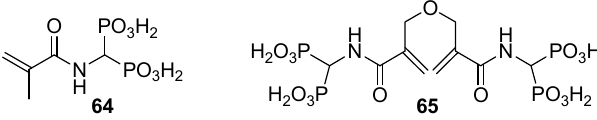
69 Scheme 33. Synthesis of polymeric nanoparticles as potential dye and drug carriers. Macromolecular co-conjugates of bisphosphonate and ferrocene were synthesized by means of Michael addition copolymerization of methylenebisacrylamide (MBA) with primary amines-6- amino-1-hydroxyhexylidene-1,1-bisphosphonate and 4-ferrocenyl-butamidopropylamine [149]. The mass percentage incorporation of ferrocene analogues was found to be between 4%–5%, and 10%–12% for bisphosphonate. Such polymers could be selectively bound to bone tissue and slowly release anticancer ferrocene derivatives at this target site.